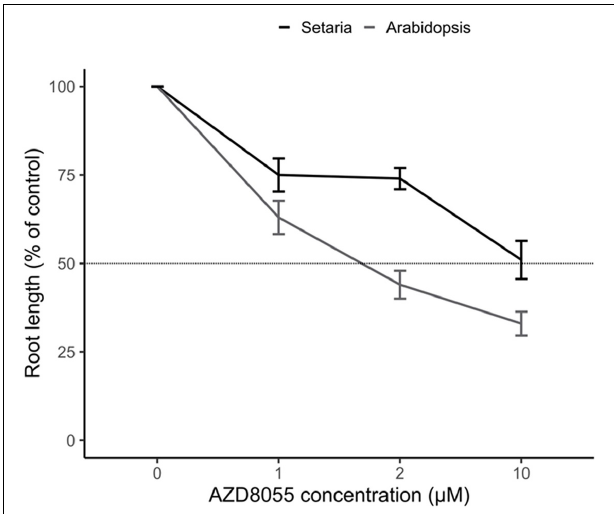
FIGURE 2 | TOR effect on root growth inhibition in S. viridis and A. thaliana . Seedlings of S. viridis and A. thaliana were grown under 12 h photoperiod until specific and compatible developmental stages before the transference to plates containing different concentrations of AZD8055 (1–10 µ M) or DMSO 0.05% (control). The effect of AZD8055 on root growth ( n = 15 roots for S. viridis or A. thaliana ) was expressed relative to DMSO 0.05% to identify the AZD8055 inhibitory concentration (GI 50 ) according to Montané and Menand